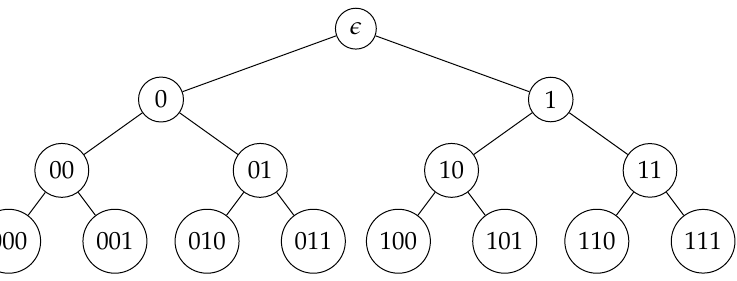
Figure 10. Labeling of nodes for the perfect binary tree M 4